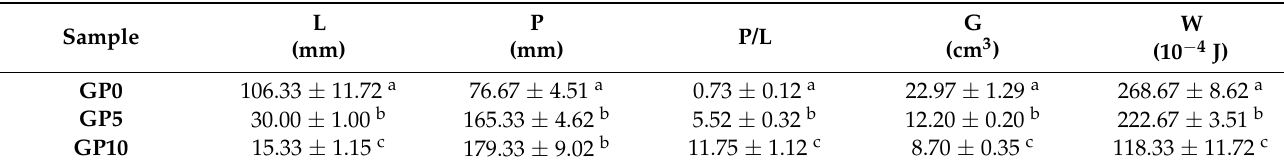
Table 2. Alveograph characteristics of dough supplemented with grape pomace